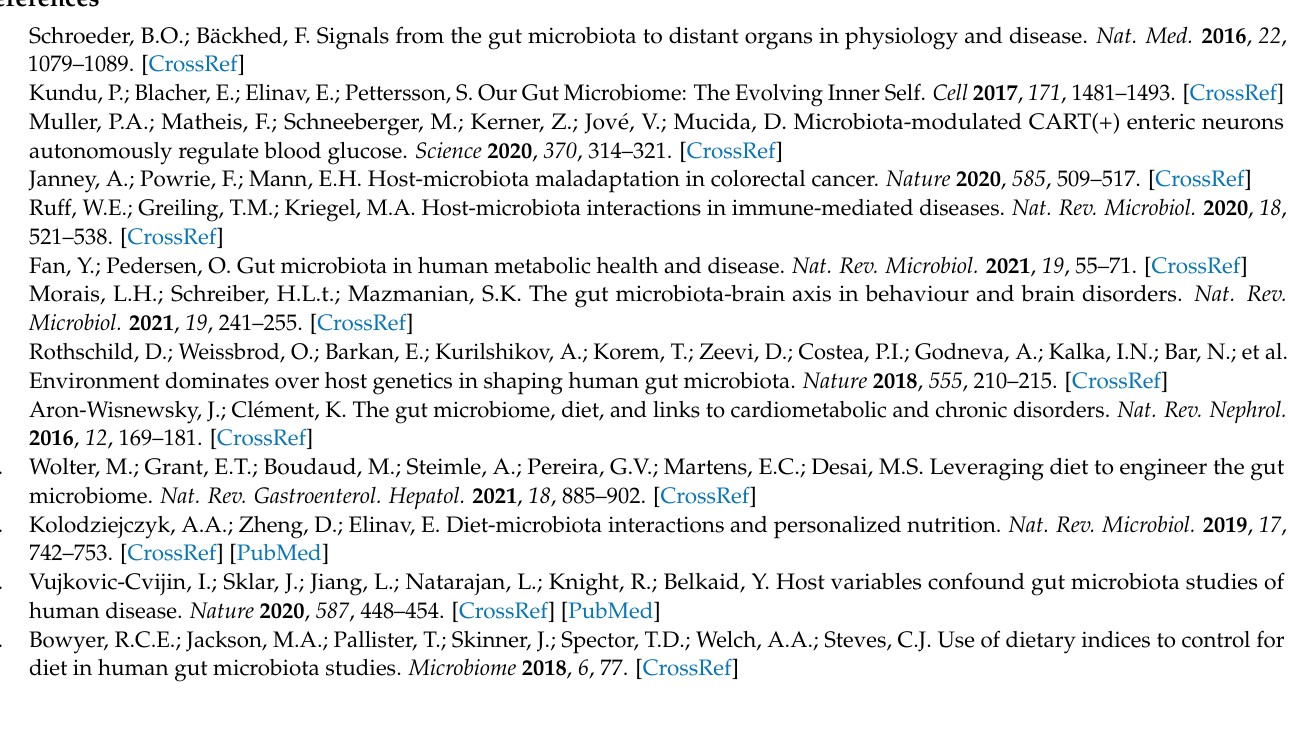
Figure S10. α -diversity indexes (richness, chao 1, simpson index, pielou index, ACE and faith-pd index in different intake frequency groups of fruits, Figure S11. α -diversity indexes (richness, chao 1, simpson index, pielou index, ACE and faith-pd index in different intake frequency groups of vegetables; Table S1. Factor loading matrix of major factors by principal component analysis with varimax rotation, Table S2. Classification of subjects by cluster analysis using factor score, Table S3. Dietary patterns identified by K-means clustering, Table S4. Region distributions of 702 participants according to the established dietary patterns, Table S5. Sensitivity analysis of associations between food intakes and gut microbial profiles using MaAsLins with population at a high risk of intestinal diseases removed, N = 479, Table S6. Sensitivity analysis of associations between food intakes and gut microbial profiles using MaAsLins among population from a single province, N = 318, Table S7. Sensitivity analysis of associations between food intakes and gut microbial profiles using MaAsLins among population with normal BMI values, N = 342, Table S8. Contingency correlation coefficient between the region variable and dietary